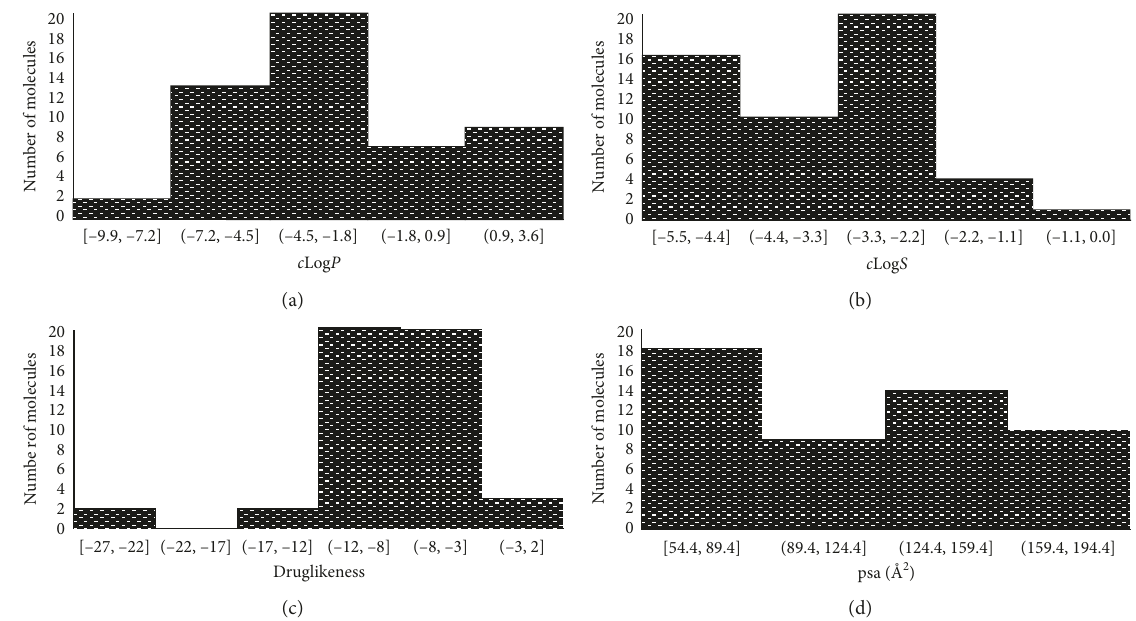
Figure 4: Distribution of (a) c Log P , (b) c Log S , (c) druglikeness, and (d) polar surface area values of the whole compounds.